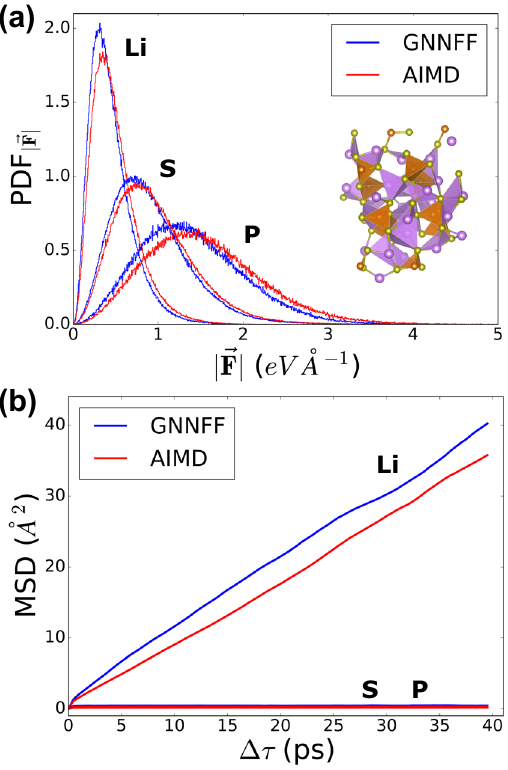
Fig. 5 Evaluating physical/chemical accuracy of GNNFF-generated trajectory of Li 7-x P 3 S 11 in comparison to AIMD equivalent. a Probability distribution functions of force magnitudes for each element. Inset fi gure shows the structure of Li 7-x P 3 S 11 obtained from the GNNFF-MD run after 50 ps. b Mean squared displacement of Li, S, and